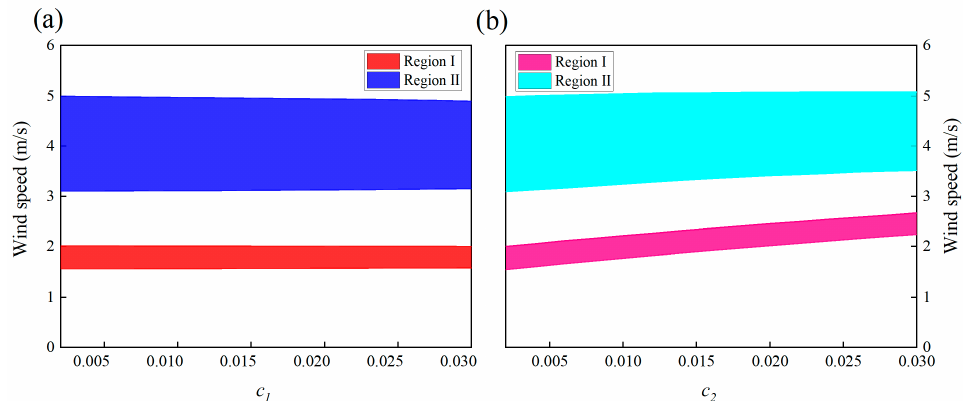
Figure 19. Effects of masses on the “lock-in” regions of the 2DOF VIVPEH: ( a ) m 1 and ( b ) m 2 .